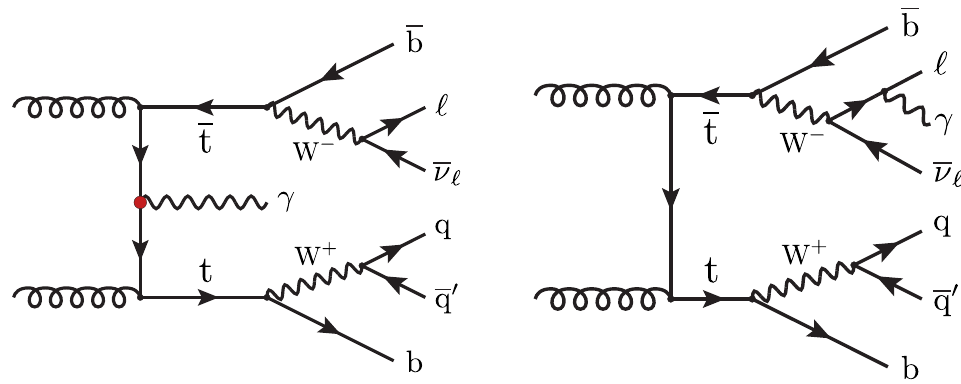
Figure 1 . Representative LO Feynman diagrams for the tt γ signal process in the single-lepton channel, where the highly energetic photon originates from the top quark (left), or is emitted from a lepton (right). The tt γ interaction vertex is indicated by a